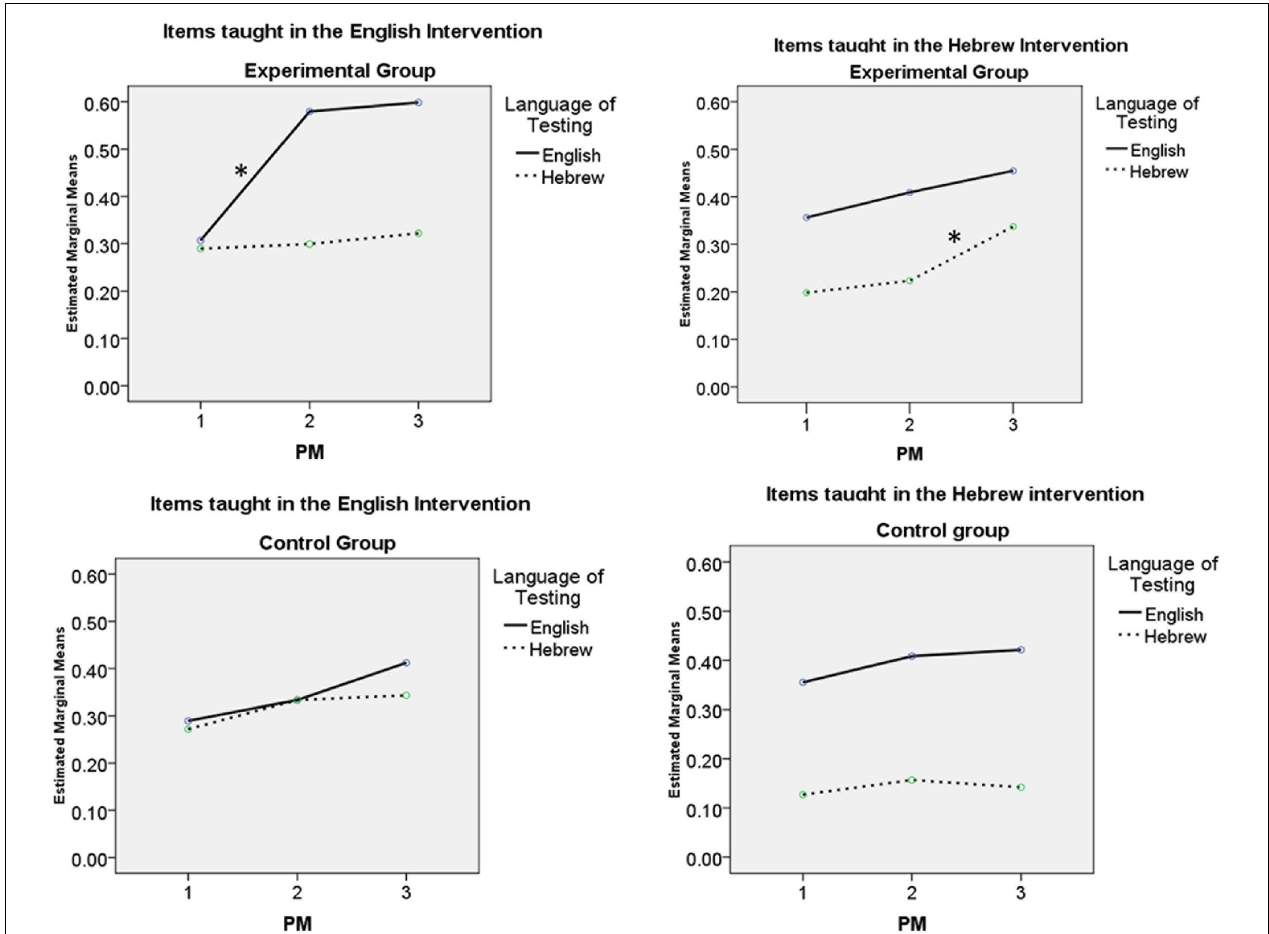
FIGURE 2 | Growth of vocabulary knowledge in English and